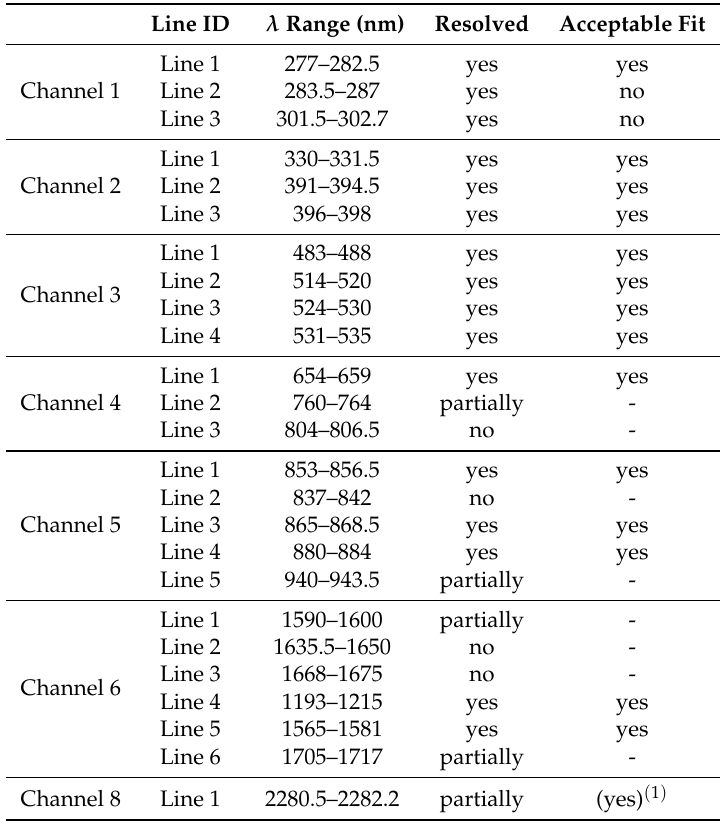
Table 3. Identified solar lines for the fitting in different SCIAMACHY channels. The lines that were not resolved were not fitted. Column 3 indicates whether a line had acceptable fits for our analysis. ( 1 ) Channel 8 line was an exception as this was the only one we could identify, which we used for